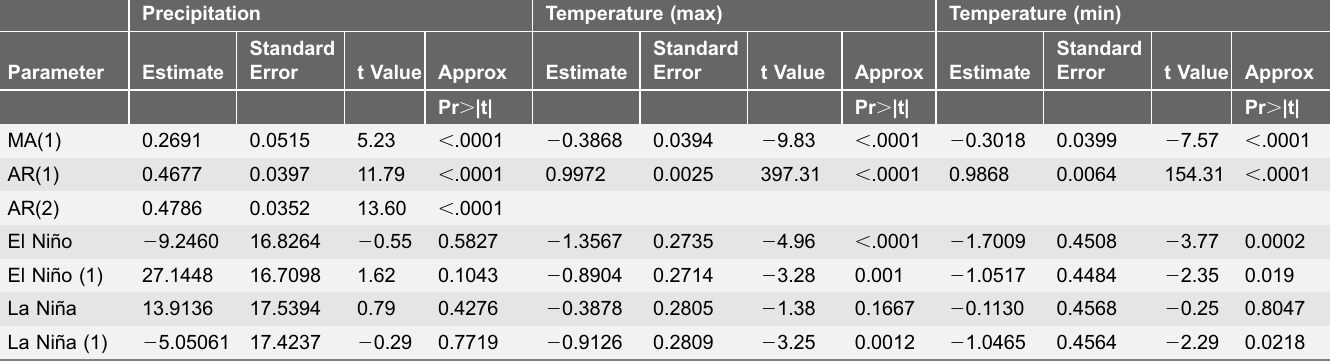
Table 1. Parameter estimates from ARIMA models of monthly precipitation, and average daily maximum and minimum temperature.